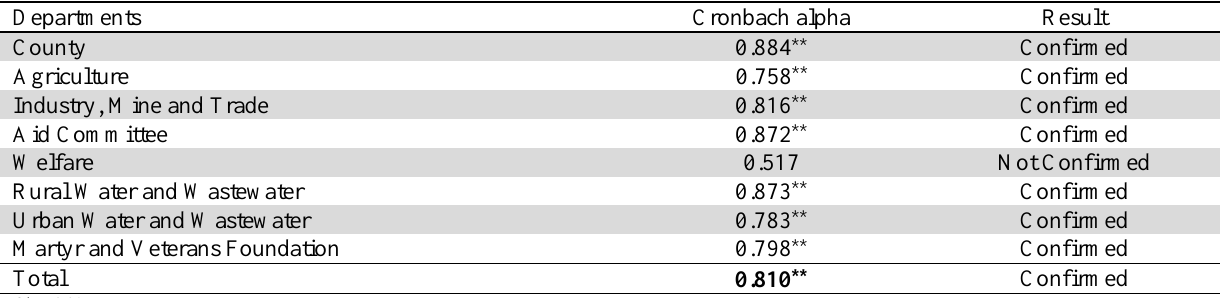
Correlation test between adaptability culture and organizational success in all departments of Khorasan Razavi